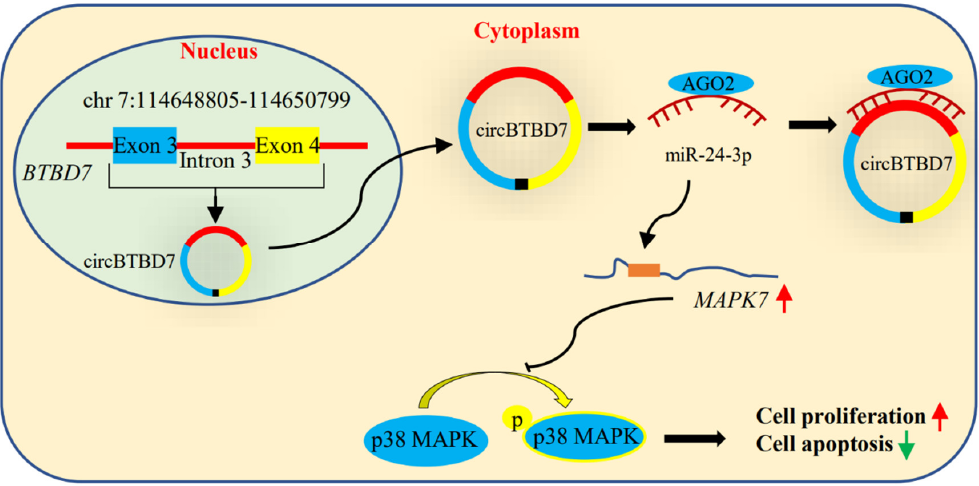
Figure 10. Model of the main finding in the present study. circBTBD7 promoted proliferation and suppressed apoptosis in immature porcine Sertoli cells through modulating miR-24-3p/ MAPK7 axis to inactivate p38 MAPK signaling pathway.